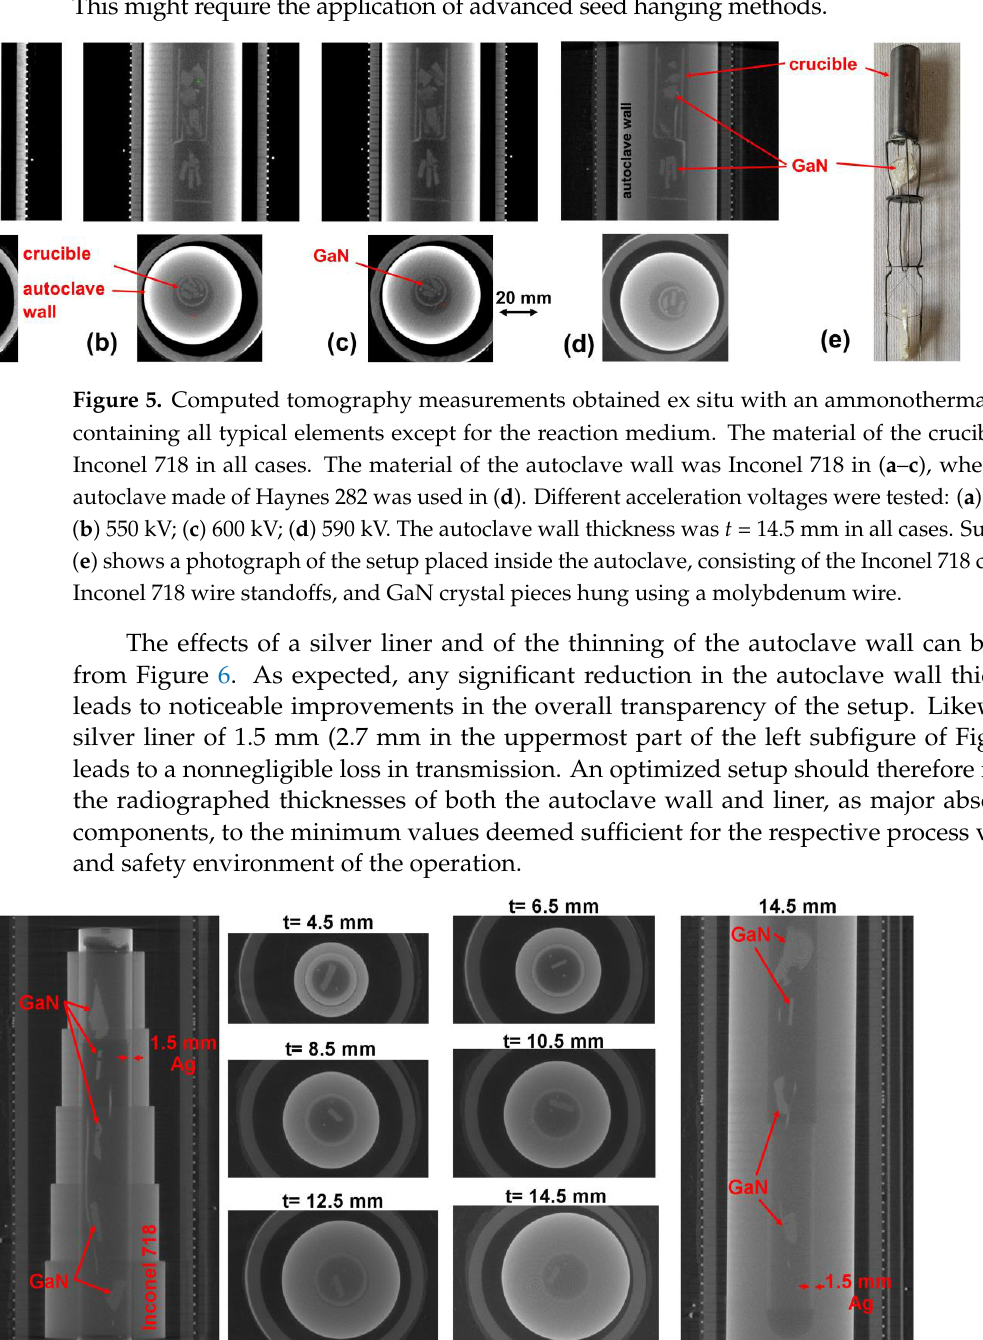
Figure 6. Ex situ computed tomography measurements obtained at 590 kV, 1 mA, and 2.5 s exposure time for each single projection image (all autoclave walls were Inconel 718). Left: vertical section through the setup with reduced autoclave wall thicknesses. Center: horizontal sections for each wall thickness. Right: vertical section of an established Inconel 718 autoclave designed for maximum operating conditions of 300 MPa and 600 °C. In the lower half, a 1.5 mm Ag tube shows the impact of a liner. The thin, lengthy, unlabeled objects in the vertical sections (also visible as a pair of dots in the horizontal sections) are Cu wires used as a standoff for hanging the GaN